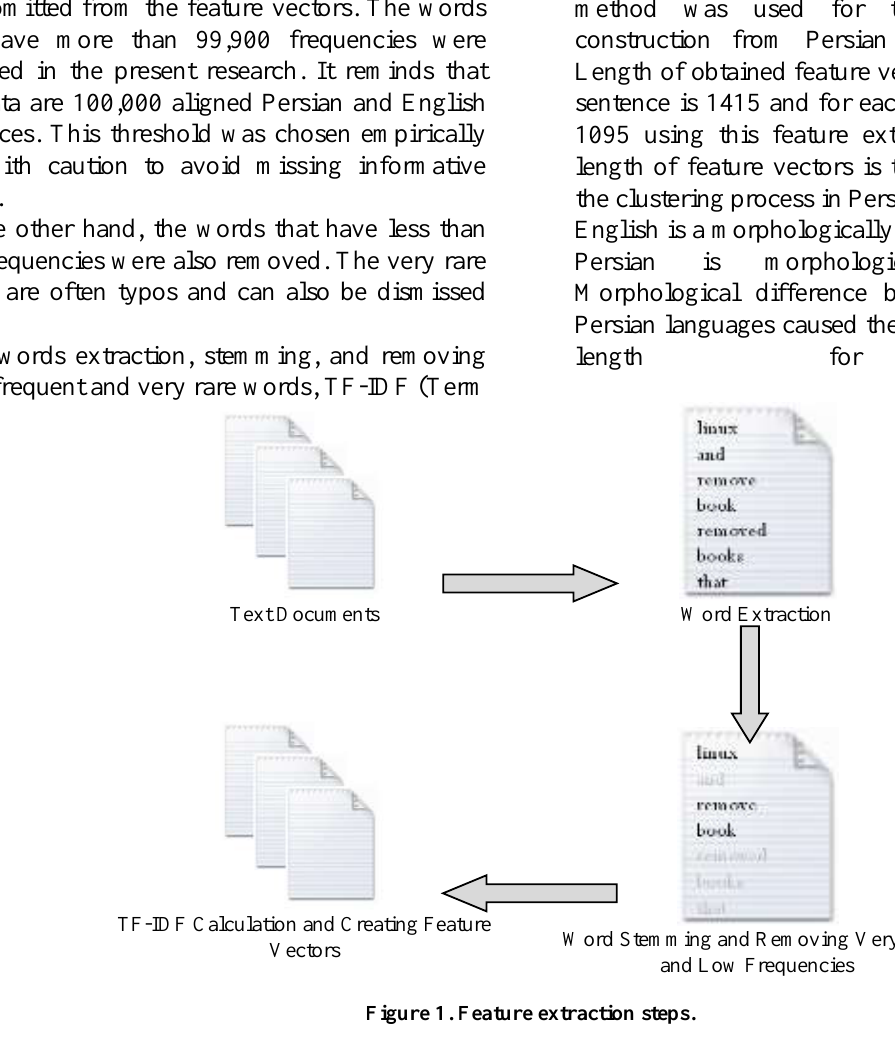
Figure 1. Feature extraction